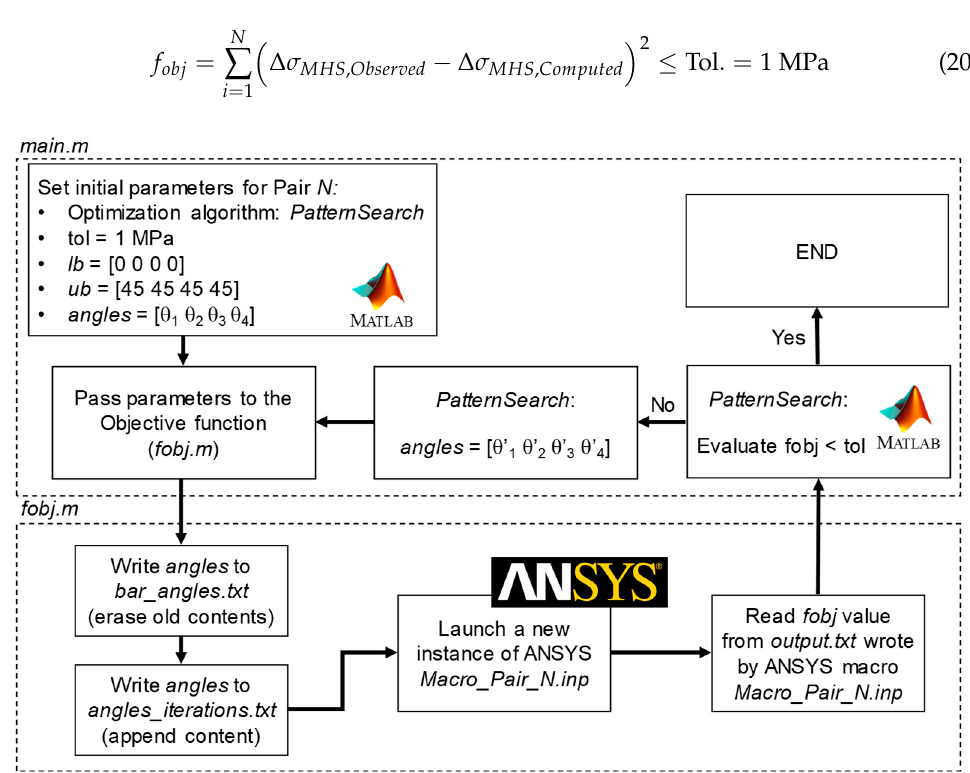
Figure 10. Flowchart for the calibration procedure of web gaps test setup for each girder pair: MATLAB/ANSYS framework.